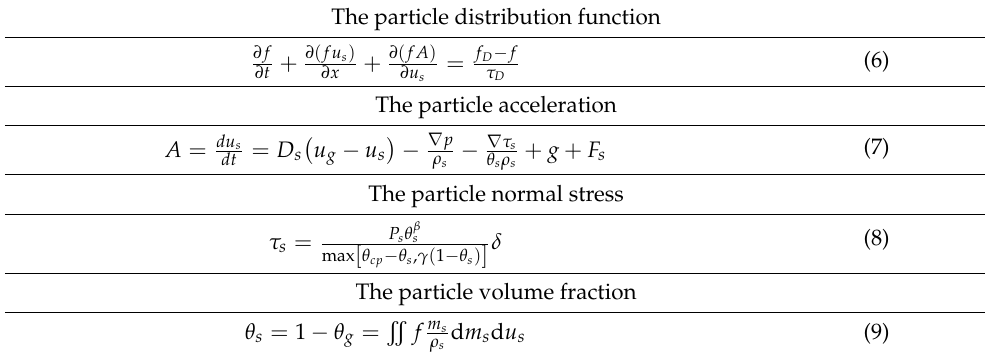
Table 2. Governing equations for solid phase. The particle distribution